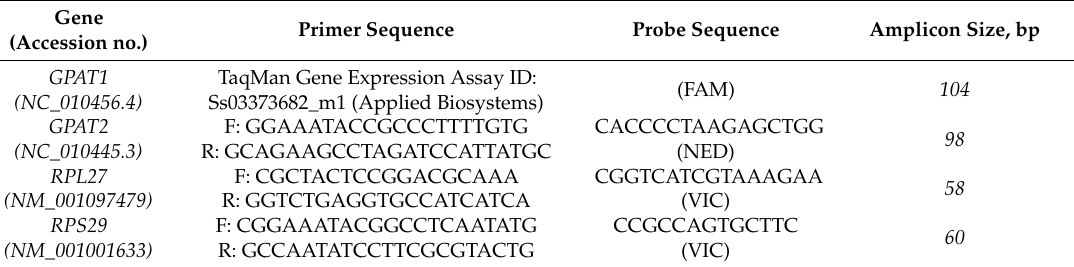
Table 1. Primers and probes used in real-time